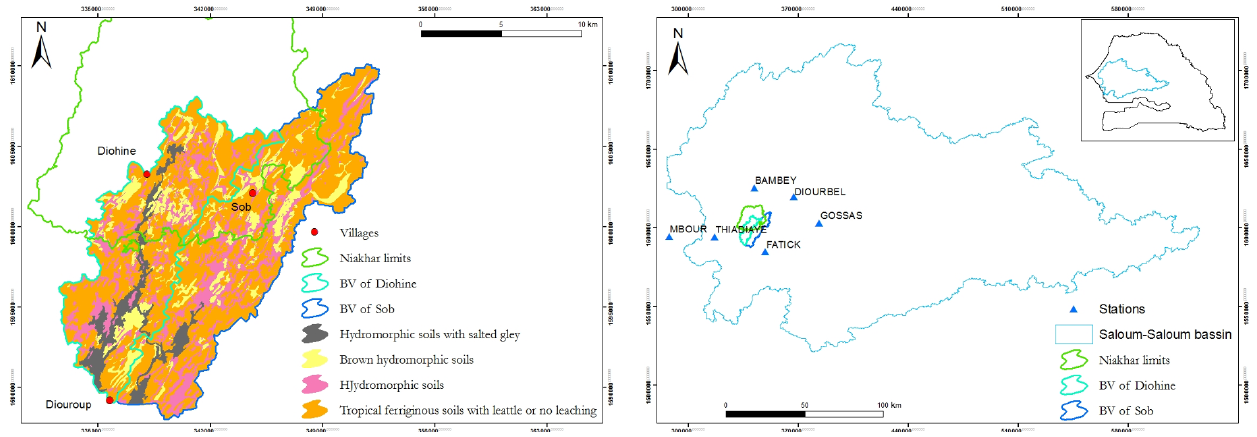
Figure 1. Location of the Sob and Diohine watersheds in the Niakhar Population Health and Environment Observatory (OPSE), and location of the 6 studied rainfall stations.